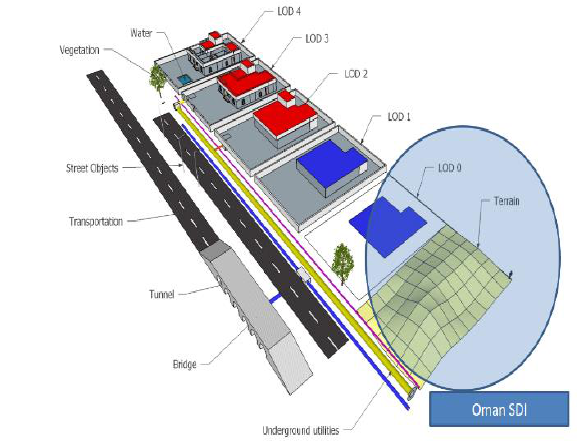
Figure 2. Oman SDI geospatial core